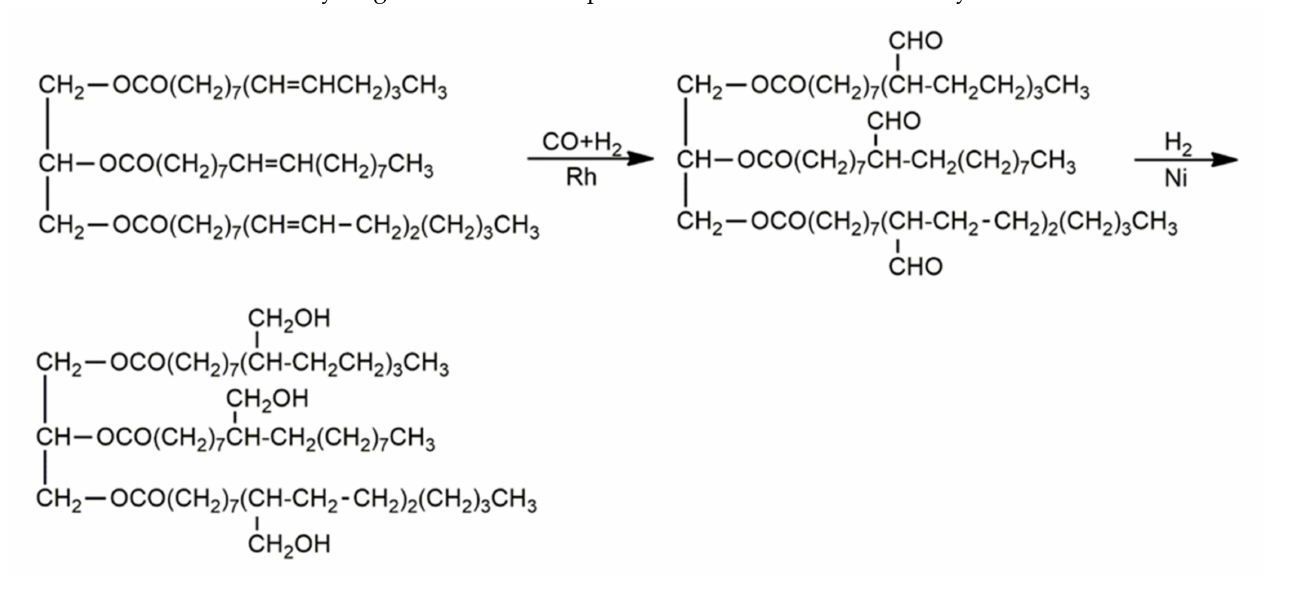
Figure 7. Introduction of primary –CH 2 OH groups by hydroformylation and